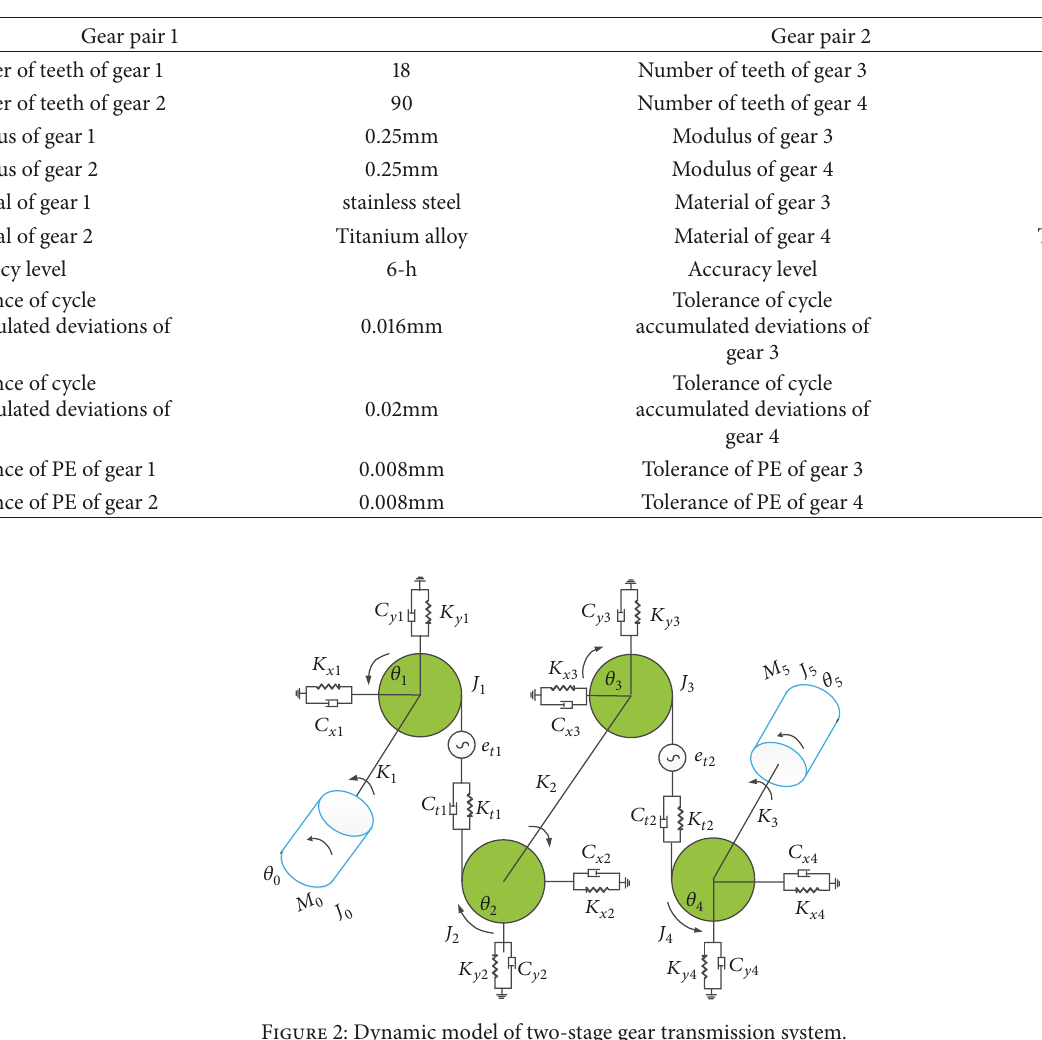
Table 1: Two-stage gear drive system parameters.